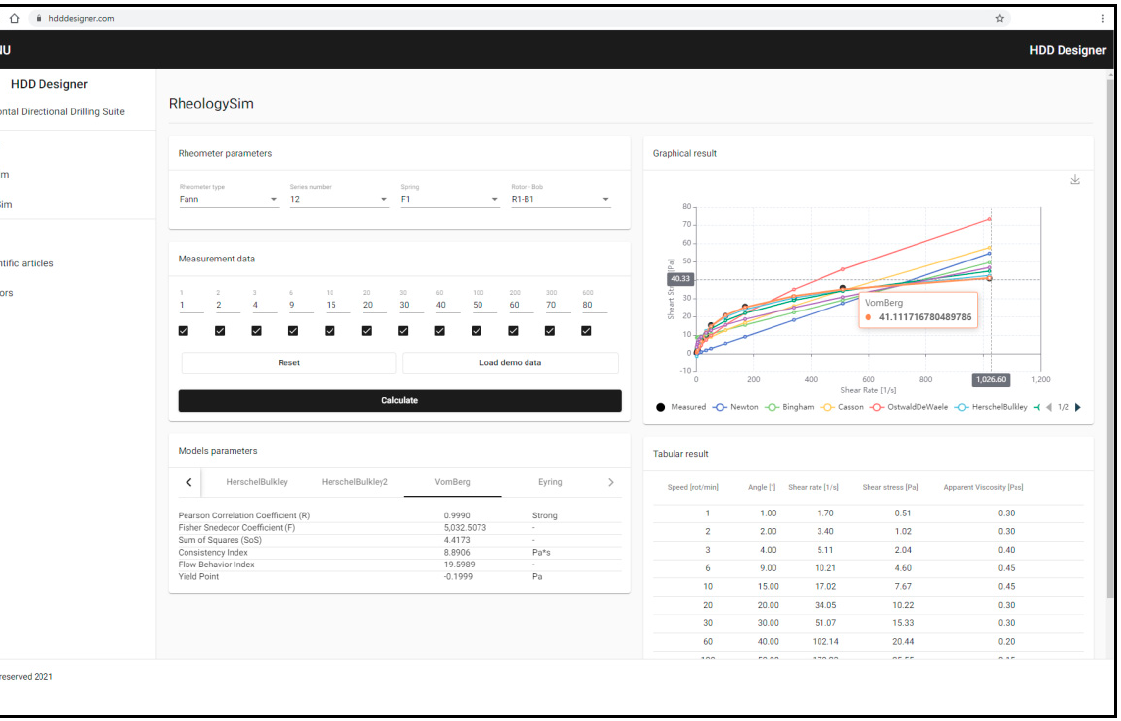
Figure 6. Graphical user interface (GUI) of the HDD Designer. The HDD Designer is available on www.hdddesigner.com (accessed on 10 June 2022).